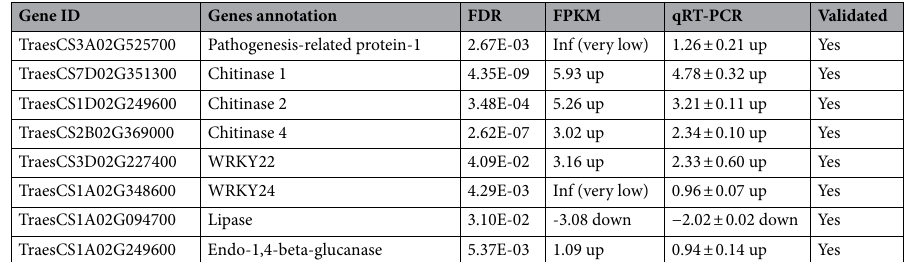
Table 2. Validation of RNA-Seq data by quantitative real-time PCR (qRT-PCR). Expression level of selected DEGs between mock- and T. controversa -infected